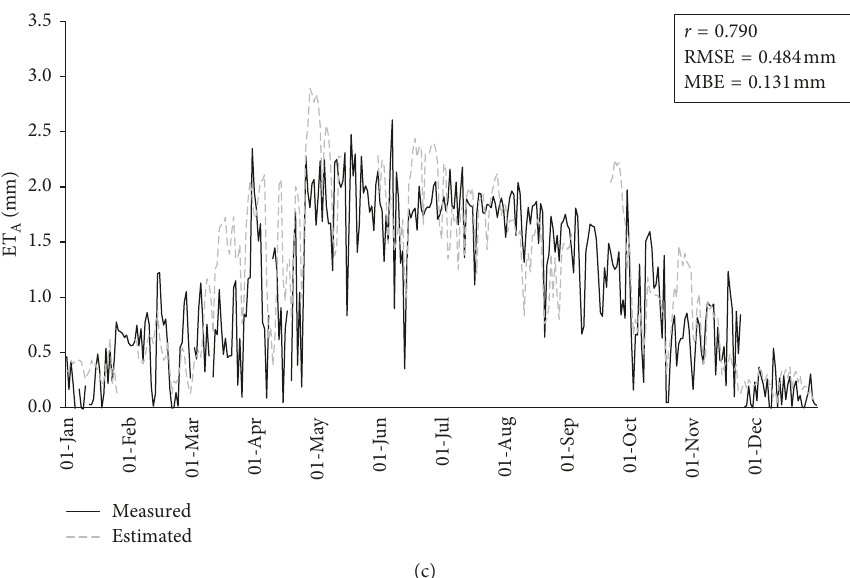
Figure 4: Annual evolutions of daily precipitation (PREC) and potential evapotranspiration (ET (b), and measured and estimated ET A (c) for San Rossore (all correlations are highly significant, P < 0 .